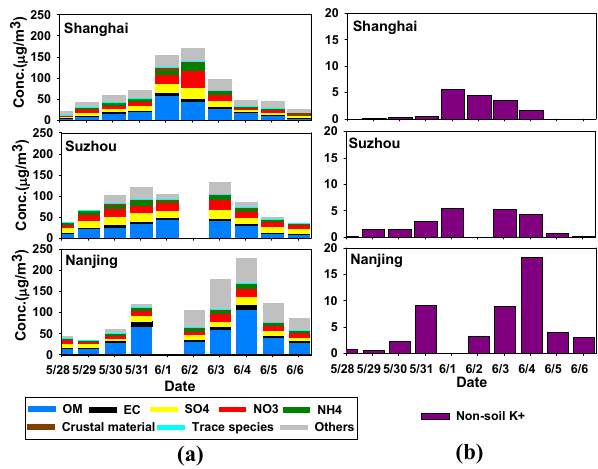
Fig. 3. (a) Daily average concentrations of PM 2.5 with chemical components. (b) Concentrations of non-soil soluble potassium (K + ) in PM 2.5 . Organic Matter (OM)=1.55OC, Crustal material =2.2Al+2.49Si+1.63Ca+2.42Fe+1.94Ti, Trace species=As+Br +Cr+Cu+Mn+Ni+Pb+Rb+Se+Sr+Zn, Non-soil K + =K + –0.6Fe, Others = PM 2.5 mass – (OM+EC+SO4+NO3+NH4+ Crustal material +Trace species+ Non- soil K + ). No data available for Hangzhou and Ningbo.